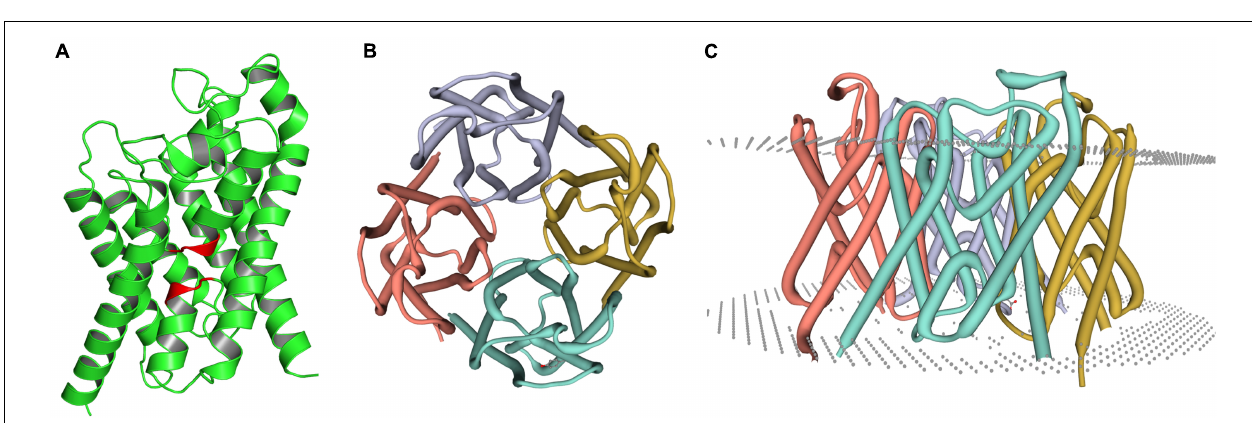
FIGURE 4 | Molecular models of HqAQP1. The homology models were generated with the Swiss-Model Workspace using crystal structures of the human AQP10 (PDB ID: 6f7h) as templates. (A) The monomers model of HqAQP1 and the NPA sequence are labeled red color; (B) The tetramers model of HqAQP1; (C) The transmembrane model of HqAQP1. The double-layered cell membrane structure annotation is indicated by the gray